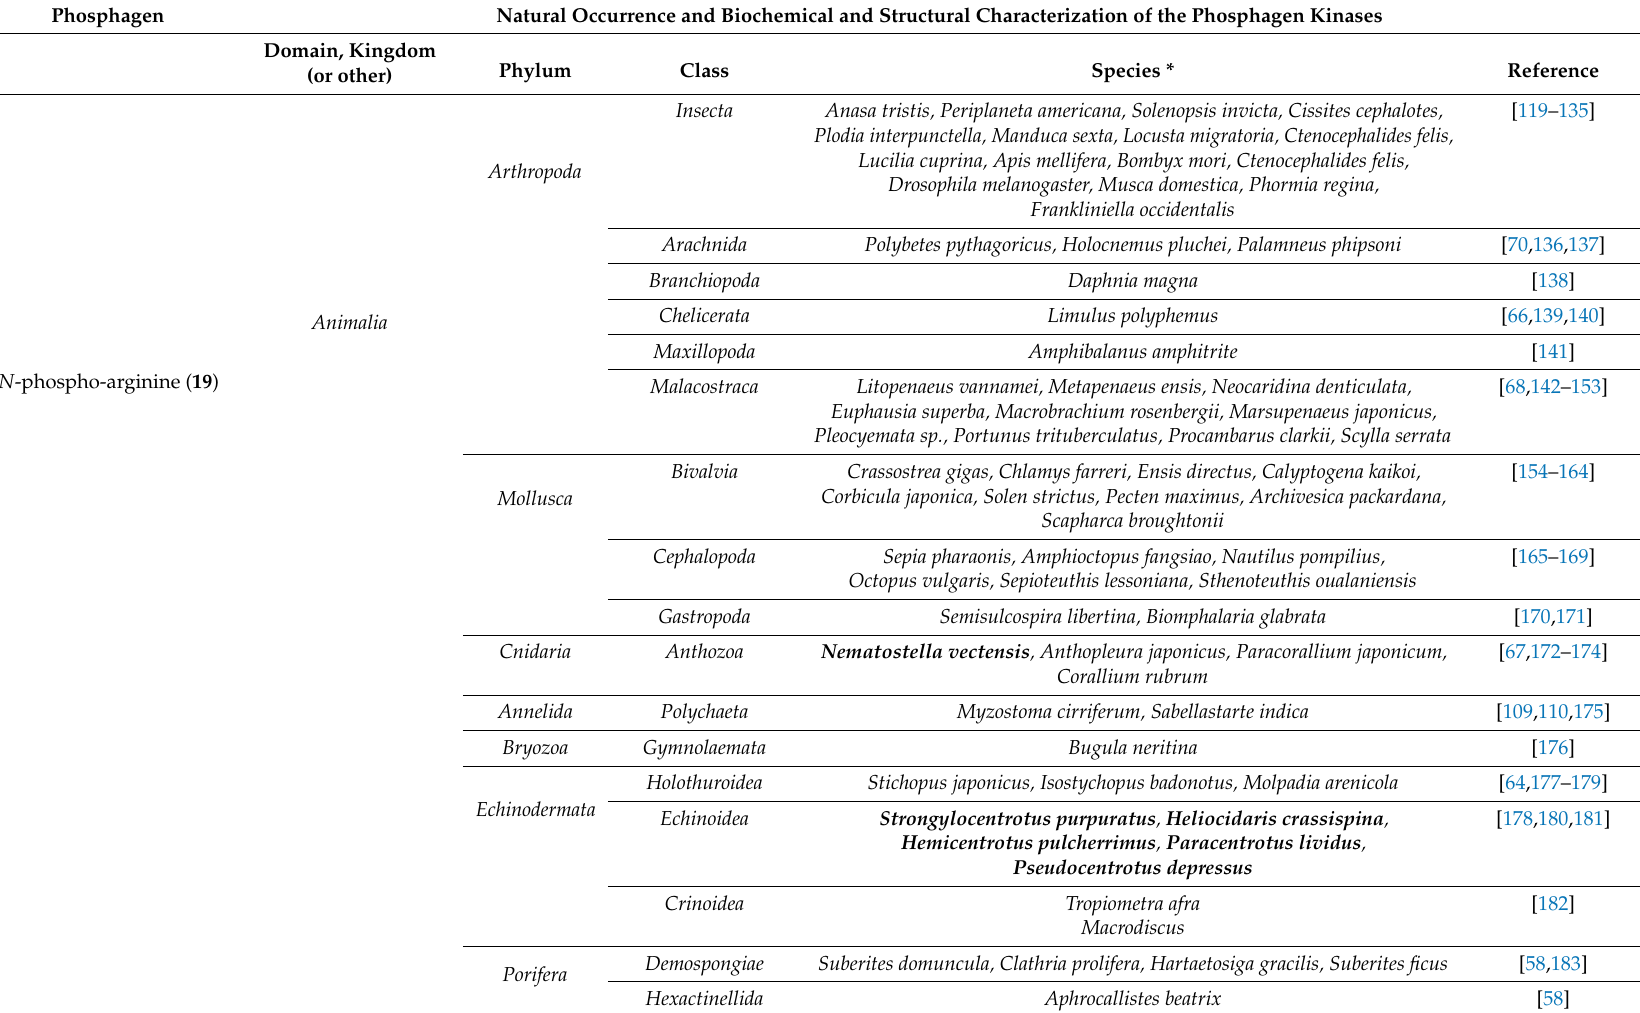
Table 1. Natural occurrence and biochemical and structural characterization of phosphagens and phosphagen